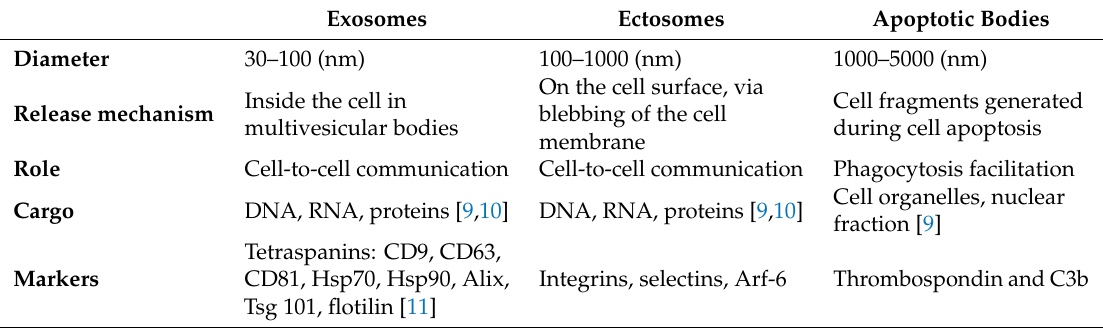
Table 1. Characterization of EV populations according to diameter, biogenesis, physiological role, cargo and typical